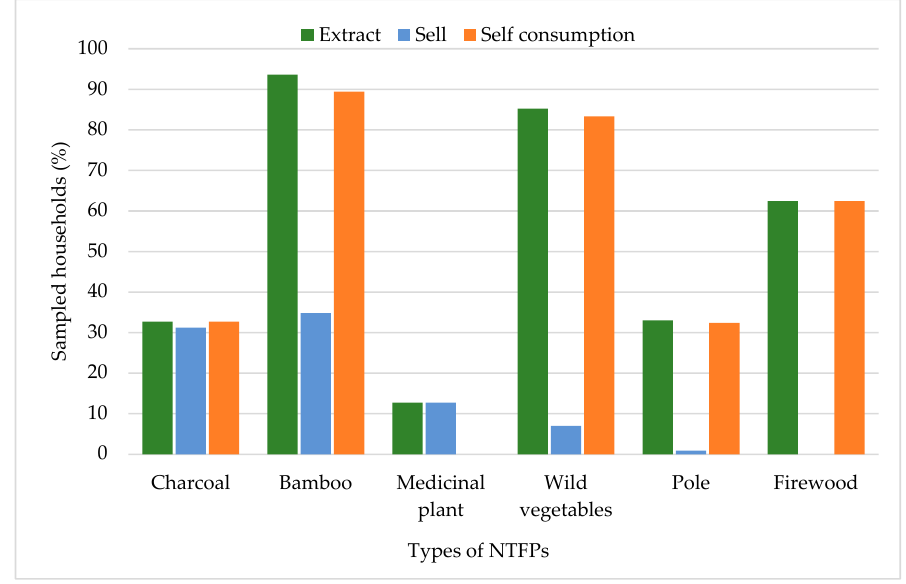
Figure 2. NTFP utilization pattern by sample households . NTFPs: non-timber forest products.